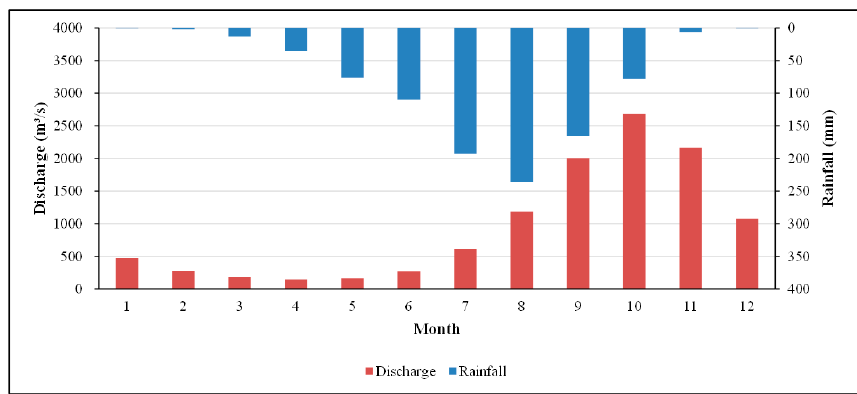
Figure 4. Seasonal variations of river discharge and regional average rainfall of the whole